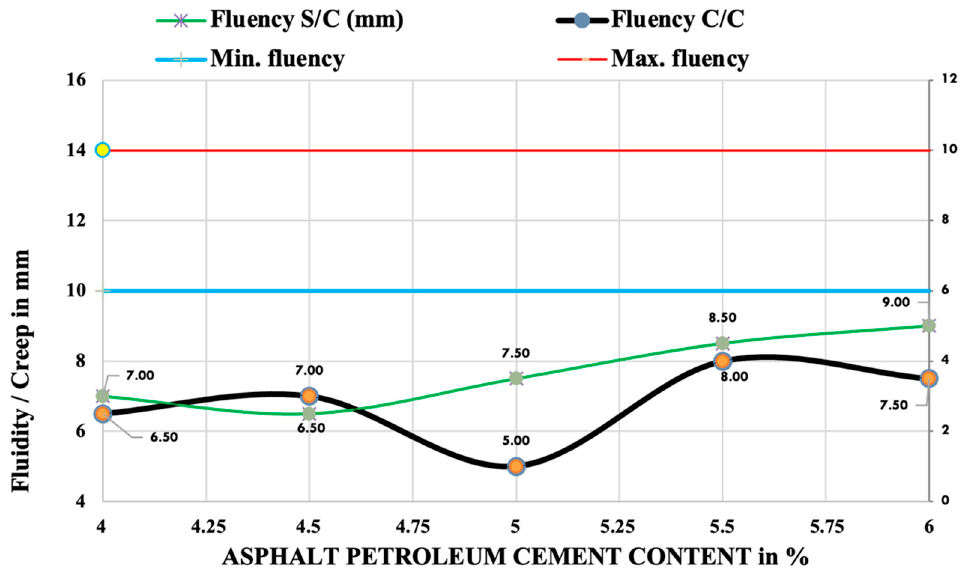
Figure 6. Creep test result.